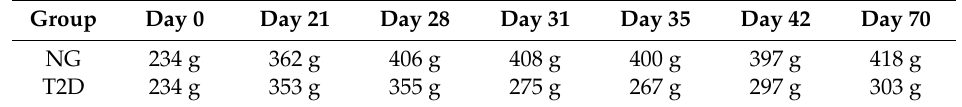
Table 3. NG and T2D body weight average at evaluated